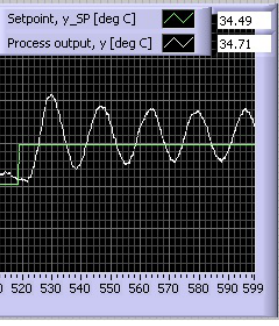
Figure 11: Ziegler-Nichols’ Ultimate Gain method: Re- sponse with ultimate gain.